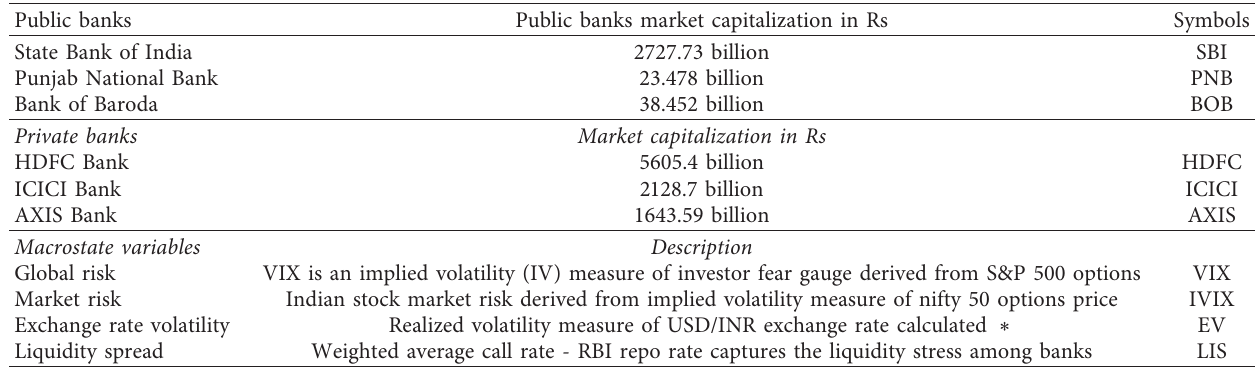
Table 1: List of banks and macrostate